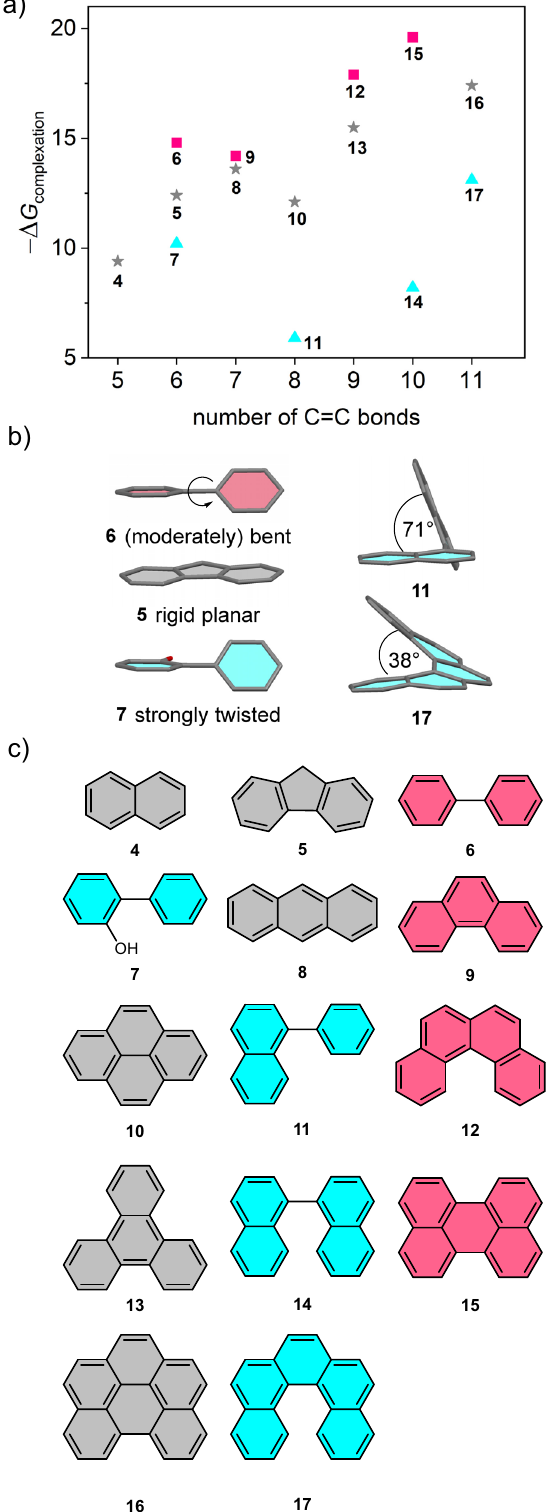
Fig.3|Bindingstudies.a PlotofGibbsfreecomplexationenergiesat295Kversus the number of C=C double bonds of the guests ’ π -scaffold. The guests are classi- fi edinthreegroups:guestswithamoderatelybentoreasilybendablestructurethat can adapt to the receptor (red), guests with a rigid planar structure (grey) and guests with a strongly twisted three-dimensional structure (blue). b Energy mini- mizedstructures by DFTofselectedguest molecules and ( c ) chemical structureof the substrates which were employed as guests in the titration studies.